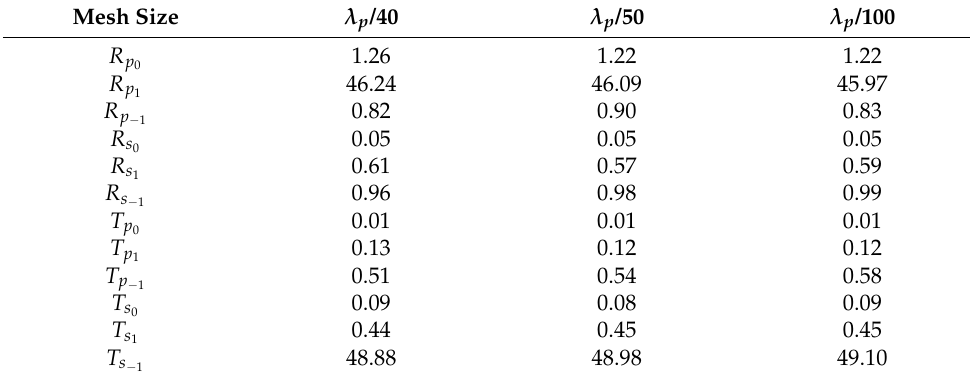
Table 1. Diffraction efficiency with different sizes of mesh (%).